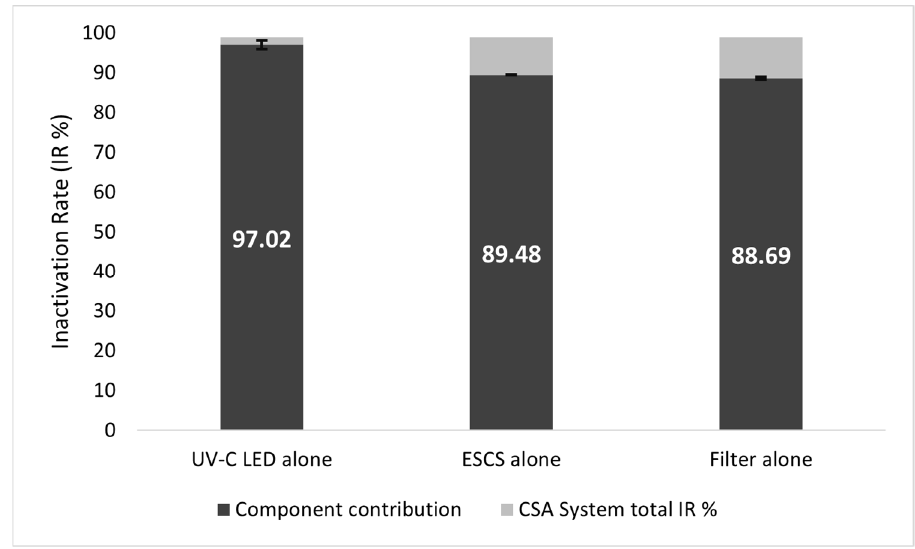
Figure 5 . Contribution of each CSA system component to air sanitation efficiency in the test rig configuration.